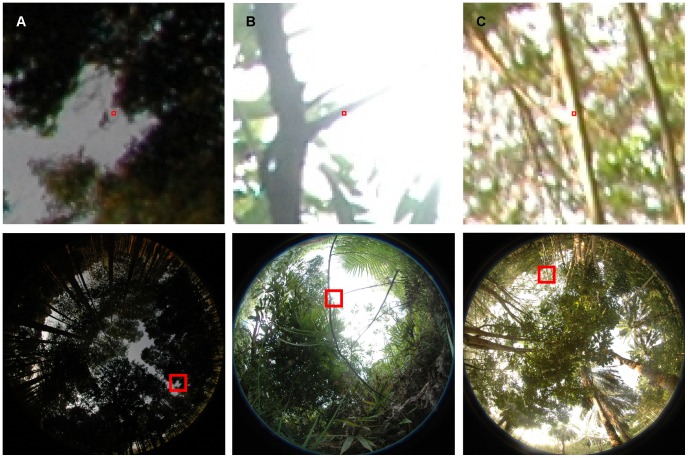
Examples of reference pixels.(A) Pixel with a low gray value in a dark region of the sky; (B) blooming effect (overexposed vegetation pixel); (C) reflection at vegetation.